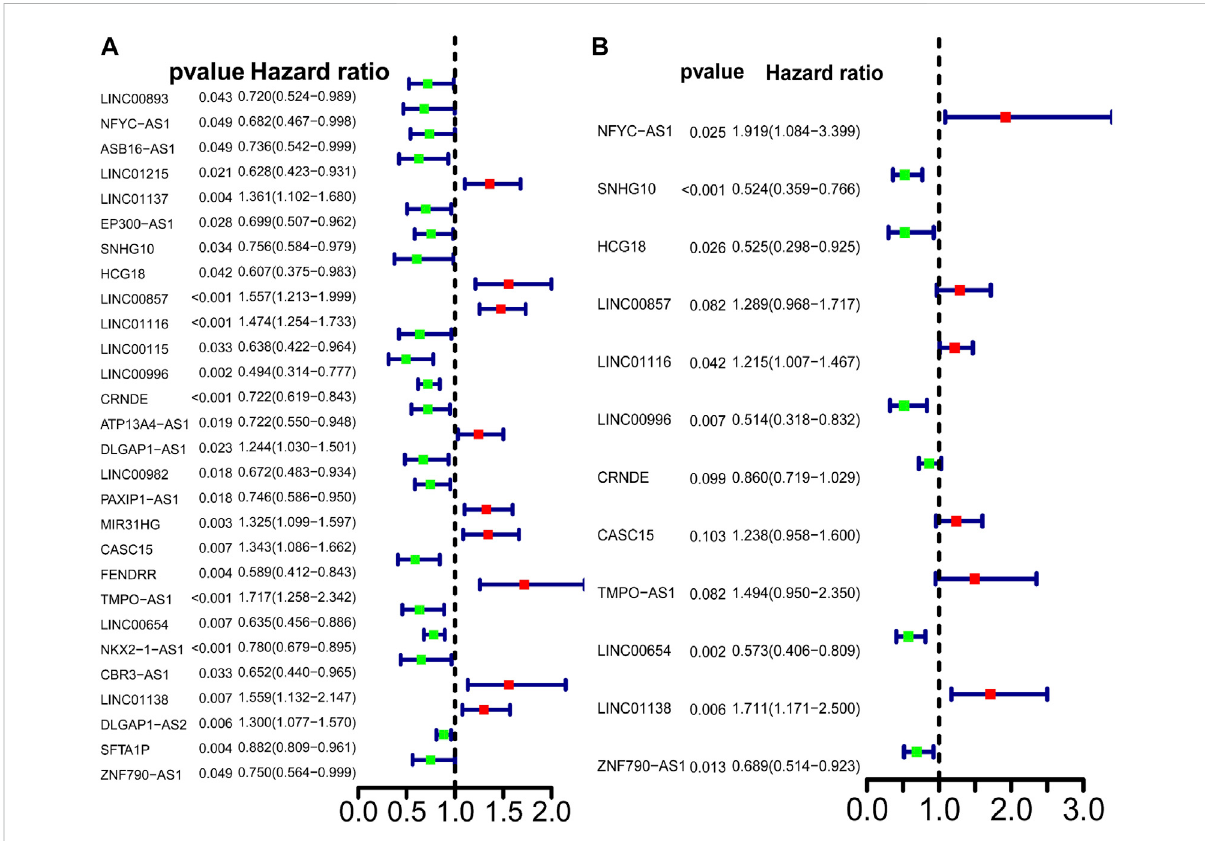
FIGURE 3 Predictive power of the differently expressed lncRNAs in LUAD patients. (A) Univariate Cox regression analysis of differently expressed autophagy-related lncRNAs. Cox analysis. (B) Multivariate Cox analysis of differently expressed autophagy-related